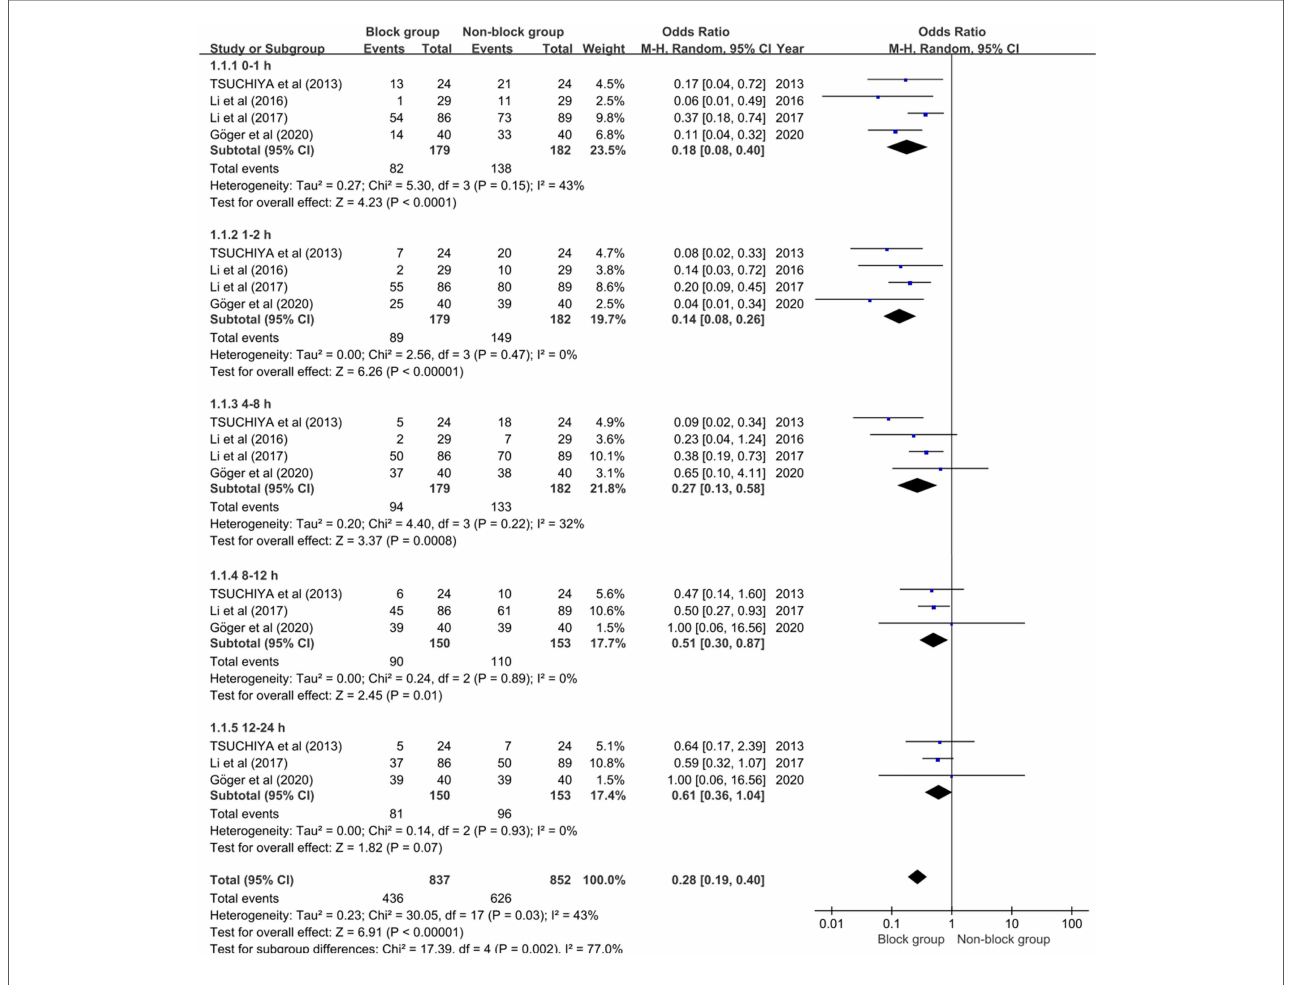
FIGURE 3 Forest plot illustrating the incidence of